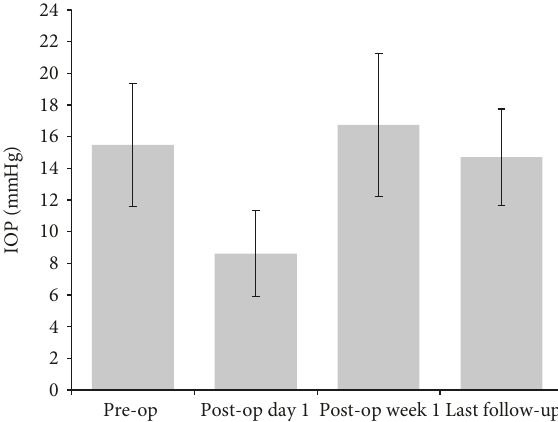
Figure 1: The intraocular pressure (IOP, mean ± standard deviation) at preoperative (pre-op), and di ff erent times postoperative (post-op). The last follow-up was 14.0 ± 4.0 months